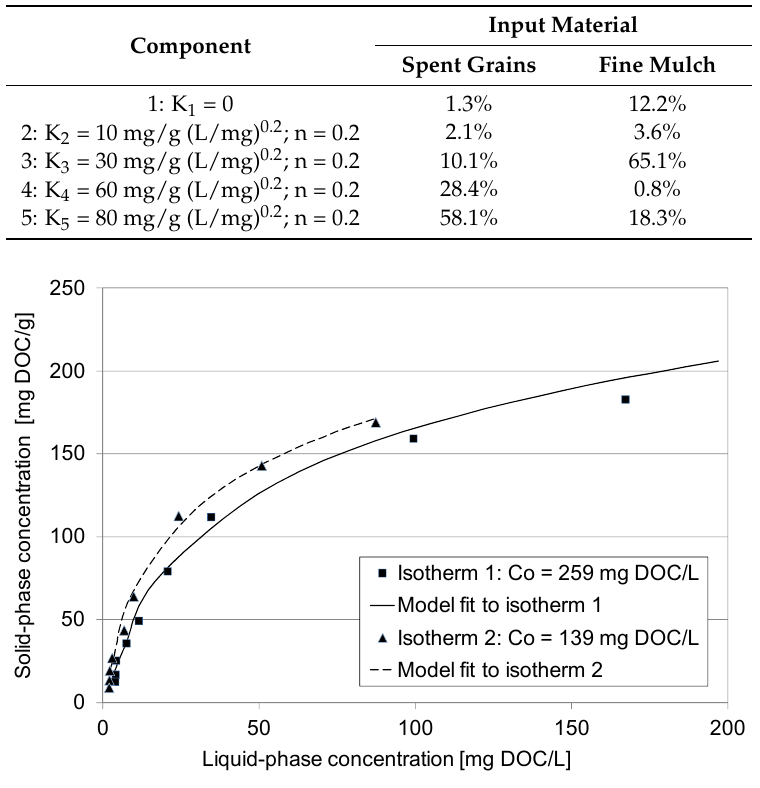
Figure 2. Overall isotherms of pre-treated HTC spent grains PW and fit of the Ideal Adsorbed Solution Theory (IAST) model.